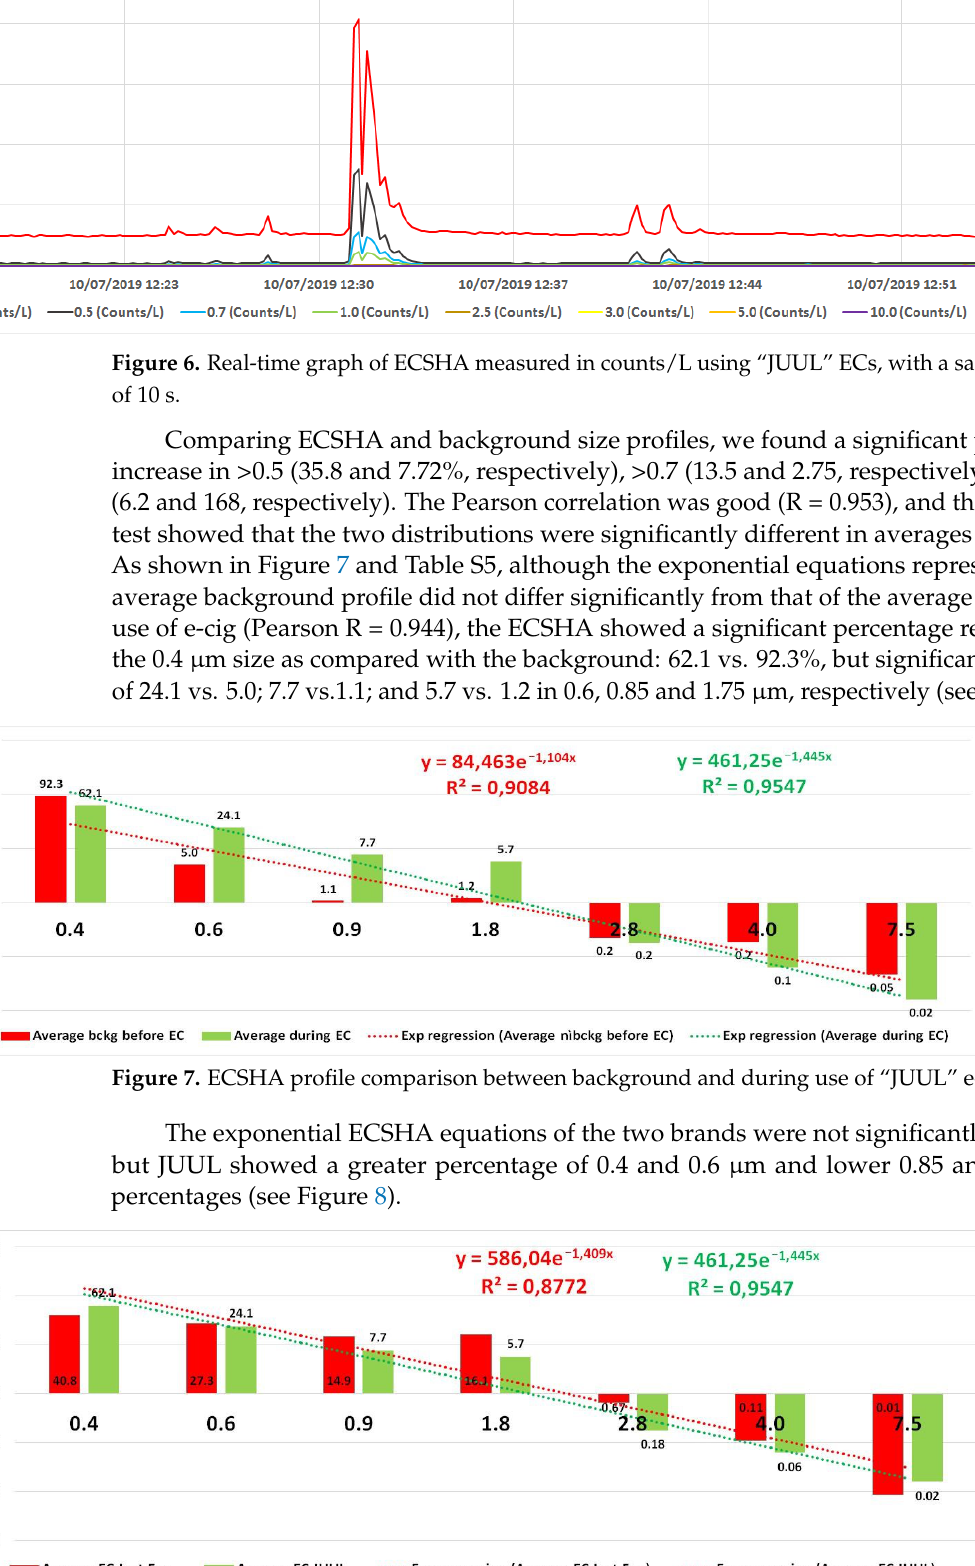
Figure 8. ECSHA profile comparison of JustFog and JUUL.